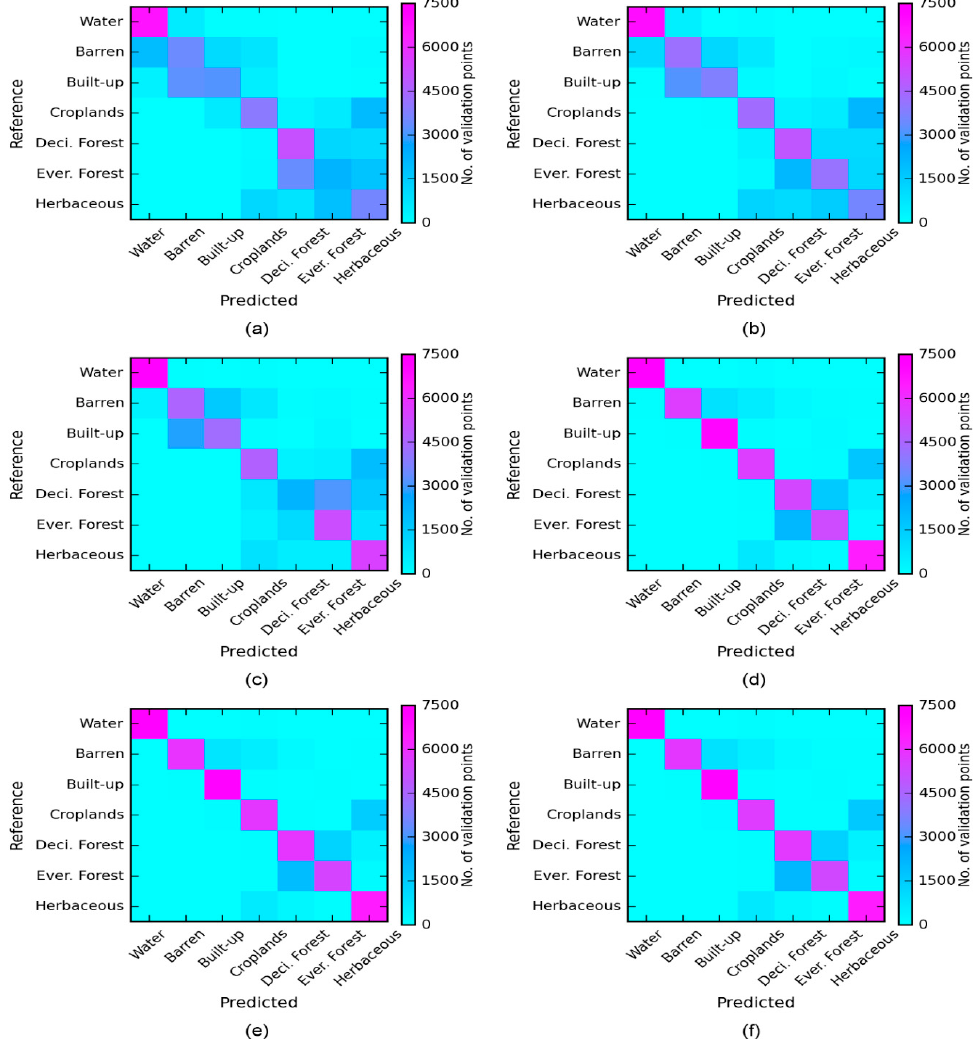
Figure 4. The confusion matrix with different numbers of best features used: ( a ) overall accuracy = 46.11%, No. of features = 1; ( b ) overall accuracy = 50.57%, No. of features = 2; ( c ) overall accuracy = 66.92%, No. of features = 5; ( d ) overall accuracy = 85.55%, No. of features = 15; ( e ) overall accuracy = 88.62%, No. of features = 45; ( f ) overall accuracy = 88.58%, No. of features = 68.